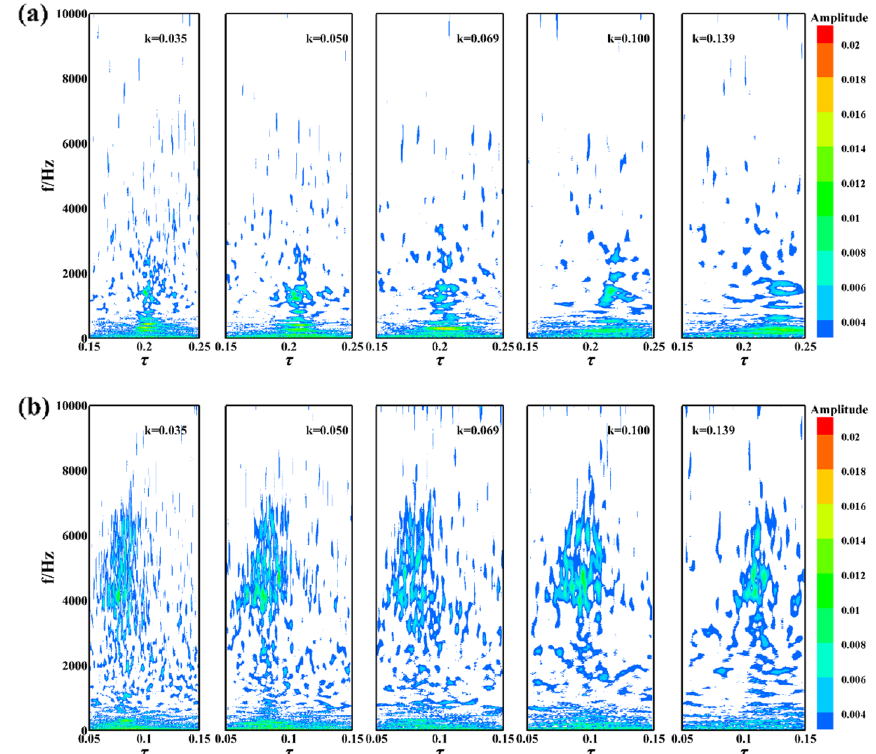
Fig. 13 Effects of reduced frequency on time-frequency characteristics of transition. a x / c